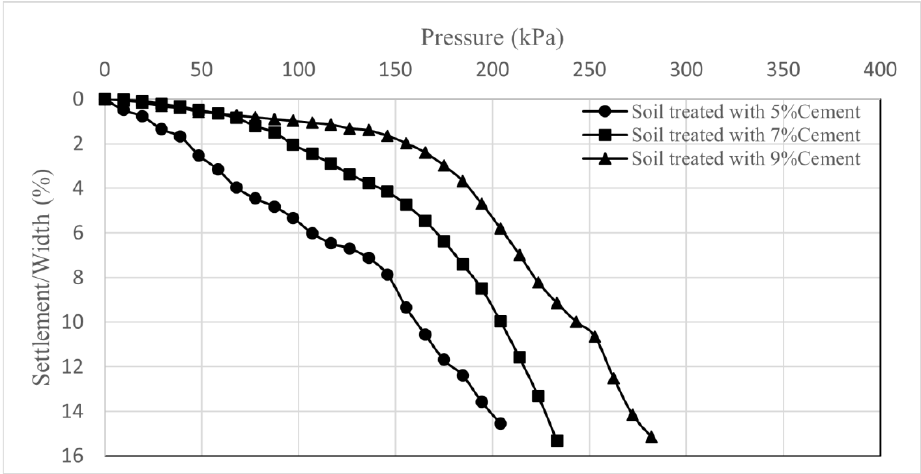
Figure 10. Pressure – settlement relationship for soil grouted with cement. Figure 10. Pressure–settlement relationship for soil grouted with